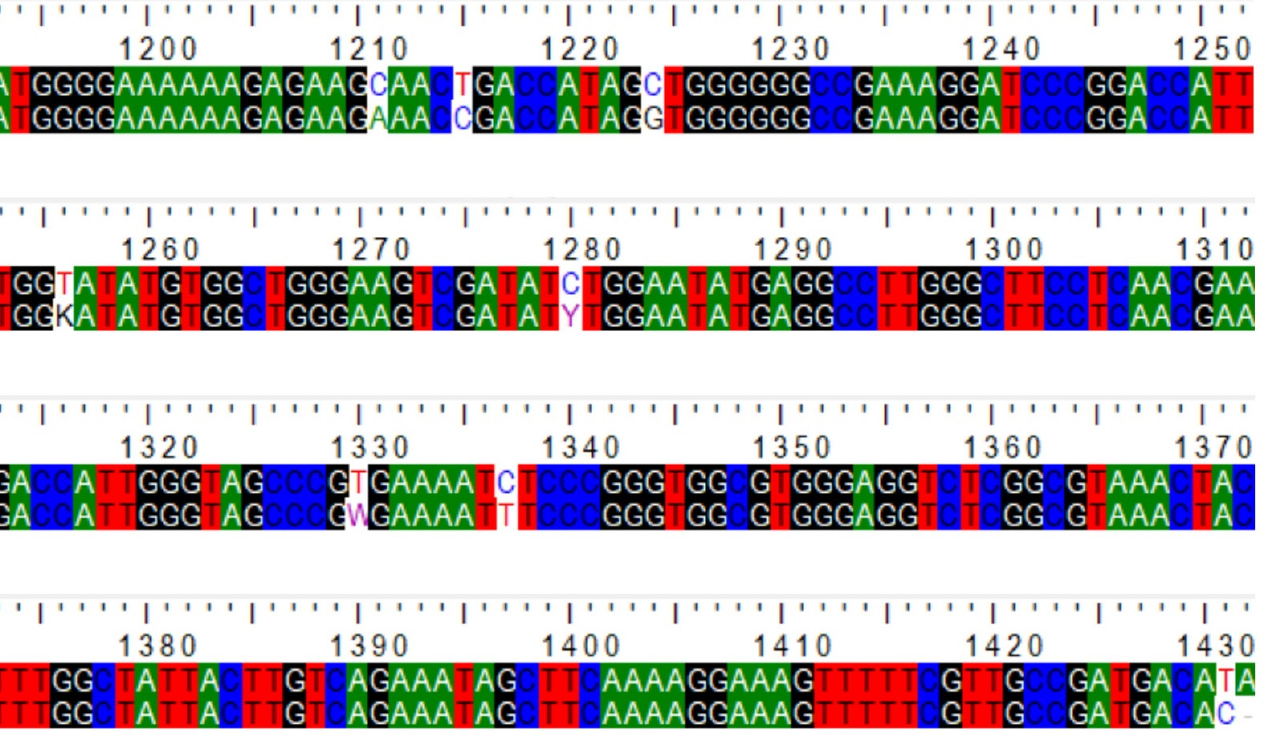
Figure 2. Alignment analysis of the query sequence (bottom) with mosquito-associated flavivirus (AY347953.2).